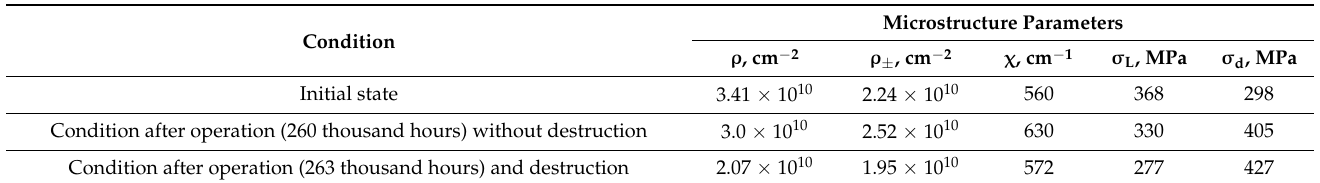
Table 5. Quantitative parameters of the microstructure of the metal of the studied samples of 0.12C-1Cr-1Mo-1V steel in the zone of localization of deformation. Transmission electron microscopy.